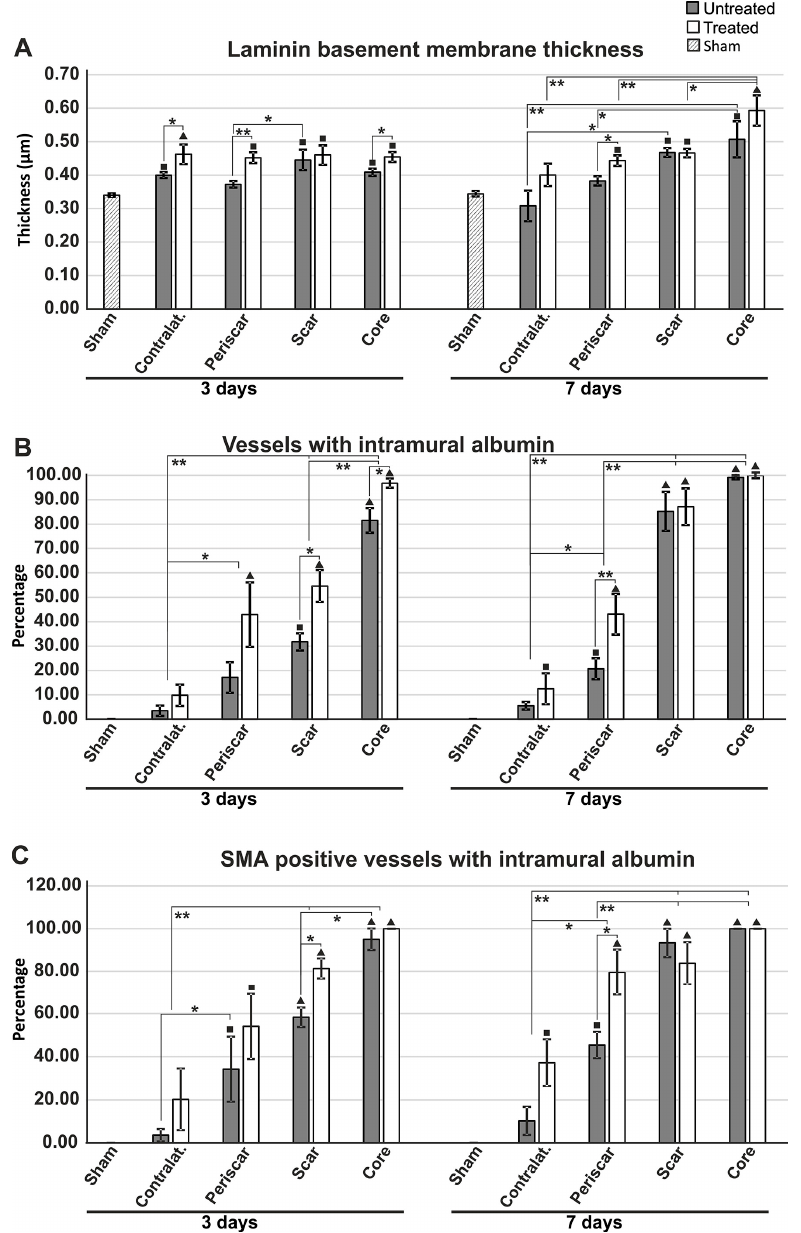
Figure 6. Characterization of the vessels with intramural albumin retention. ( A ) Direct measurement of the outermost basement membrane based on laminin immunohistochemistry reveals an increased thickness for treated animals compared to untreated animals, especially at 3 days after MCAO (in the infarct core, the ipsilateral hemisphere around the gliotic scar, and the contralateral hemisphere), while this difference was significant only for the ipsilateral peri-scar tissue at 7 days of survival; ( B ) There were more albumin-positive vessels in treated animals than in untreated ones for the infarct core and scar region at 3 days after MCAO, and in the peri-scar regions at 7 days after MCAO. Overall, there was an increase in the number of albumin-positive vessels from the distant contralateral hemisphere to the infarct core; ( C ) The percentage of larger muscular vessels (SMA-positive) being stained for albumin increases from the contralateral hemisphere to the infarct core, with a tendency toward higher values in treated animals (* p < 0.05, ** p < 0.01; ■ p < 0.05 and ▲ p < 0.01 (for pathological regions versus sham animals), using a one-way ANOVA followed by a post hoc Fisher’s LSD test, n = 5–6/group). The differences between 3 and 7 days are not included for reasons of clarity. Data are expressed as the means ± SEM.